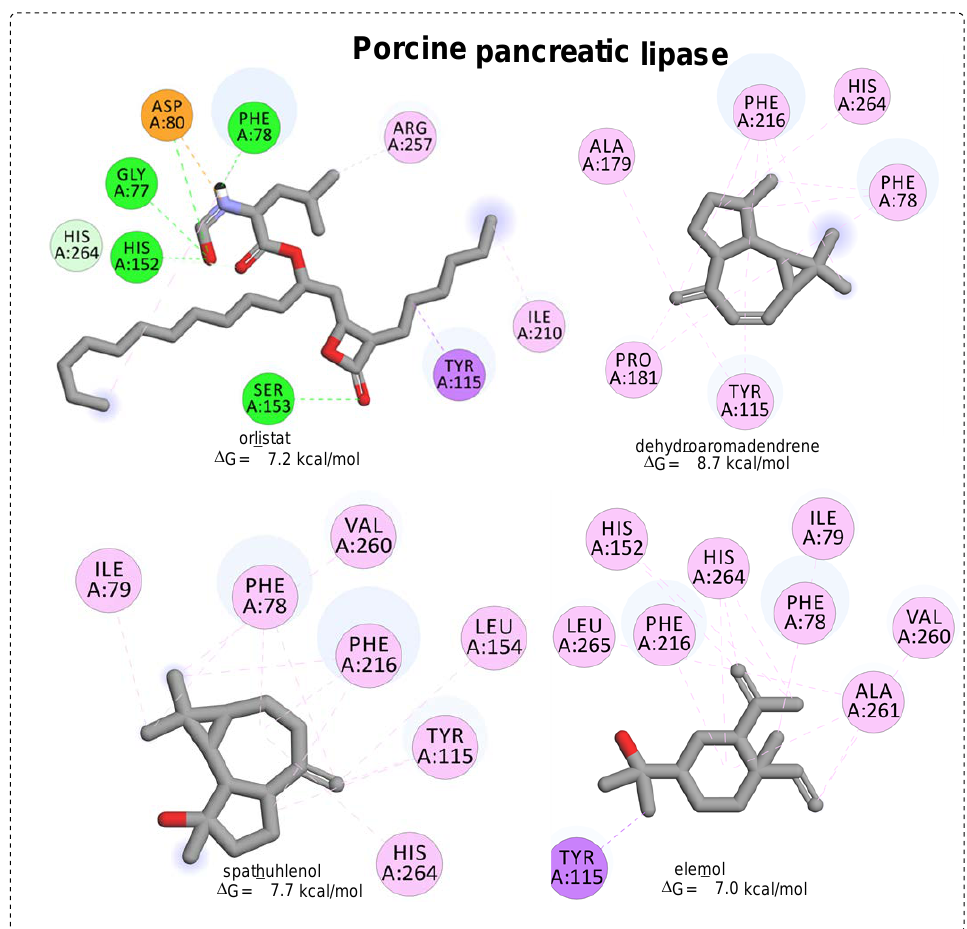
Figure 4. Main interactions observed for orlistat (positive control) and the top-scored inhibitors of porcine pancreatic lipase (1ETH) by docking analysis.